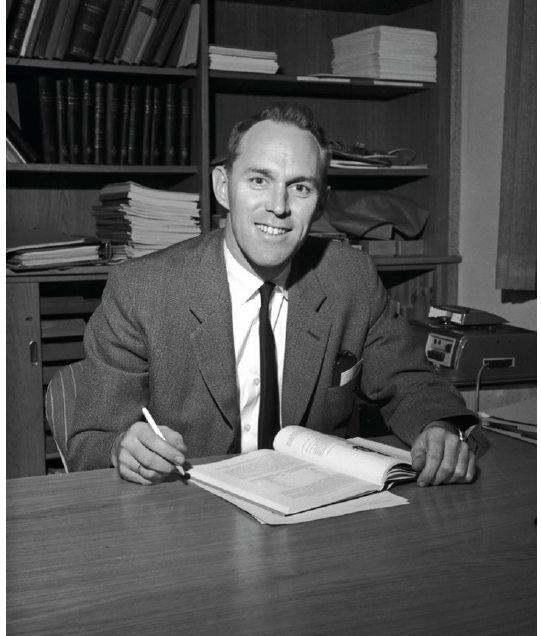
Figure 2: Jens Glad Balchen in 1961, shortly before he was appointed professor at NTH. Photo: